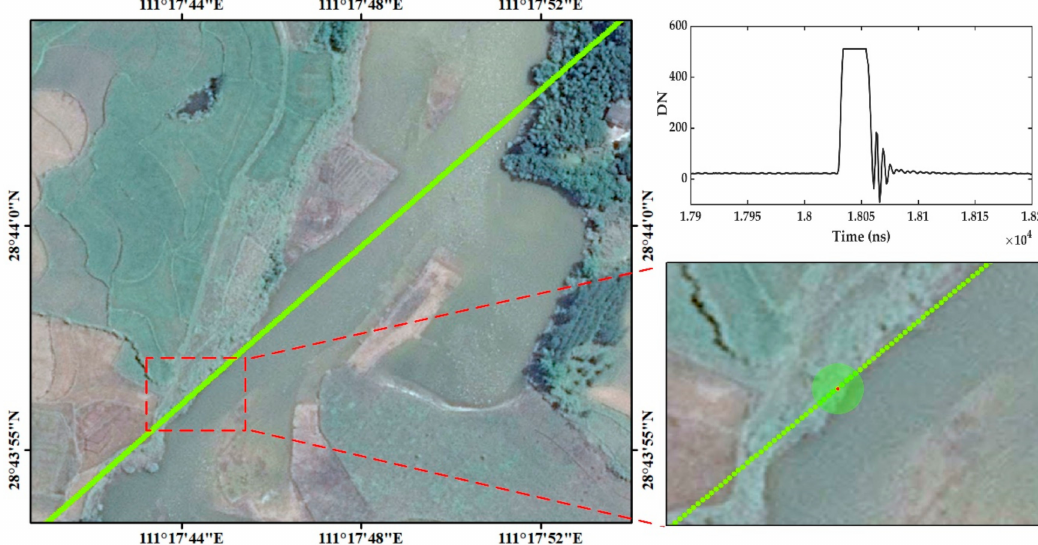
Figure 8. Schematic of an aircraft trajectory that is nearly parallel to the shore and its resulting